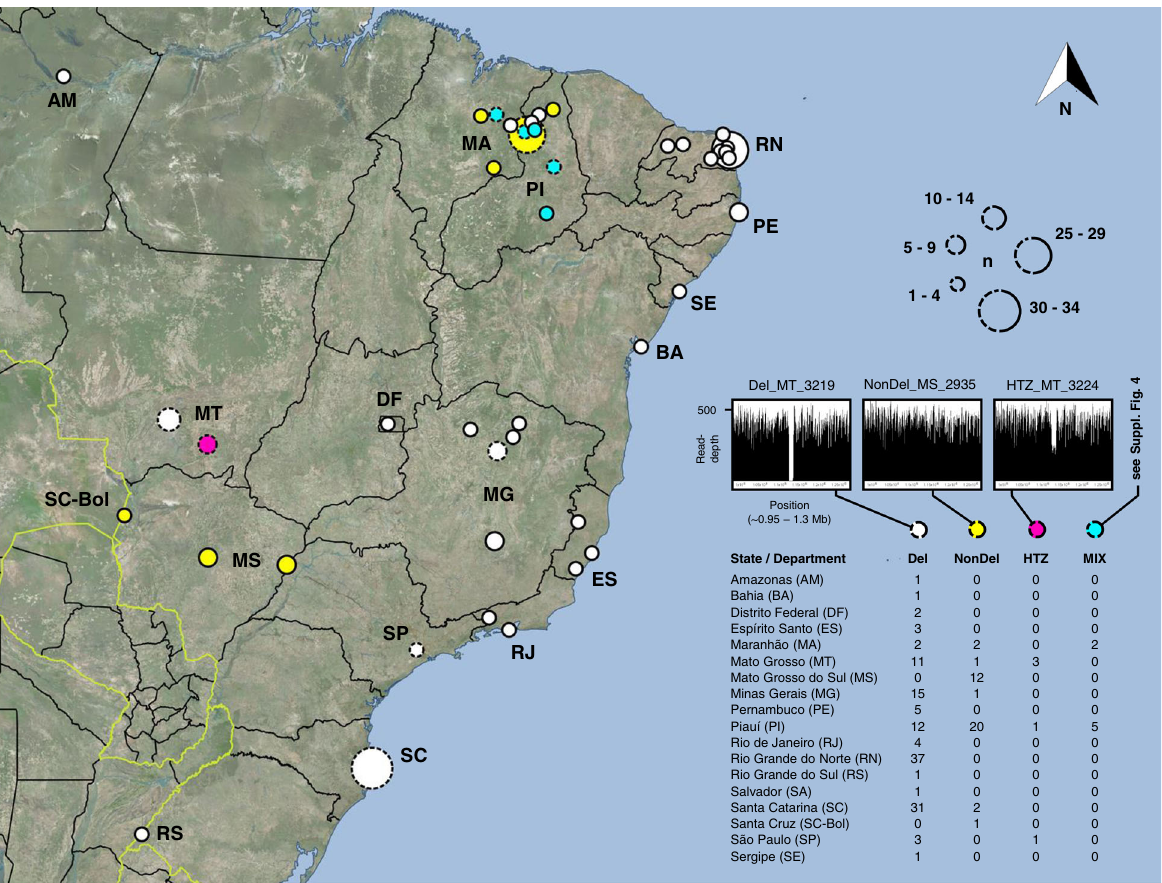
Fig. 1 Different read-depth pro fi les found in L. infantum isolates from Brazil. Del isolates contain a >12 kb deletion between 1.122 Mb and 1.135 Mb on chr31 (e.g., Del_MT_3219 in the left graph). NonDel isolates do not contain the deletion, showing full read-depth at the locus (center graph). 8HTZ isolates are heterozygous for the deletion, with read-depth dropping to ca. 50% (right graph). Quantitative PCR con fi rmed heterozygosity at the deletion locus in monoclonal HTZ subcultures. MIX isolates appear to contain a mixture of NonDel and Del or HTZ pro fi les based on subclone PCR by Carnielli et al. 27 . However, full read-depth is observed at the deletion locus in all MIX isolates, except in MIX_PI_05A and MIX_PI_08A (showing ca. 75% read-depth, see Supplementary Fig. 4). This suggests that NonDel cells are more abundant than Del and/or HTZ cells within MIX isolates. Circle radius indicates the number of isolates (each from a different canine or human host) representing the study site. Dotted circles represent study sites where multiple read-depth pro fi les occur (see table inset). Fill color indicates the majority read-depth pro fi le at such study sites. The map was created in the open-source geographic information system Quantum GIS version 2.18.4 using Open Layers plugin access to Bing Aerial imagery. Microsoft product screen shot(s) reprinted with permission from Microsoft